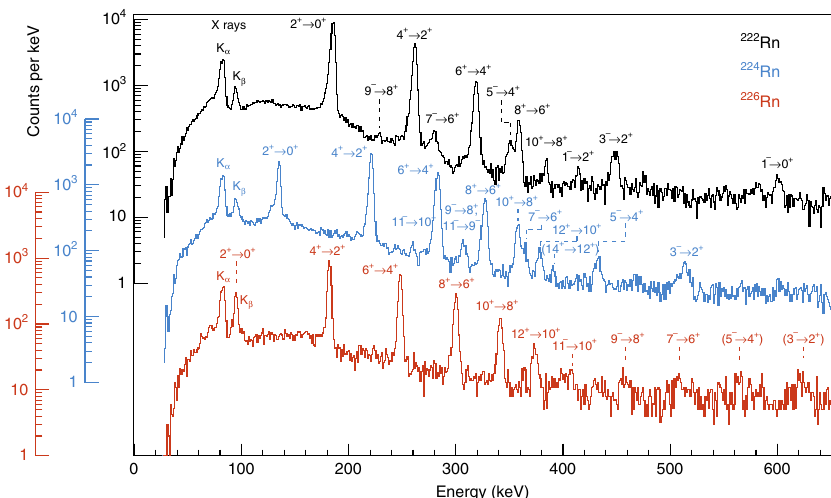
Fig. 1 Spectra of γ -rays. The γ -rays were emitted following the bombardment of 120 Sn targets by 222 Rn (black), 224 Rn (blue) and 226 Rn (red). The γ -rays were corrected for Doppler shift assuming that they are emitted from the scattered projectile. Random coincidences between Miniball γ -ray and silicon particle detectors have been subtracted. The transitions which give rise to the observed full-energy peaks are labelled by the spin and parity of the initial and fi nal quantum states. The assignments of the transitions from the negative-parity states in 224,226 Rn are tentative (see